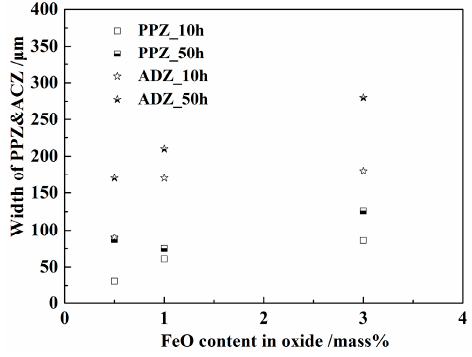
Figure 11. Influence of initial FeO content in the oxide on the widths of PPZ and ADZ.